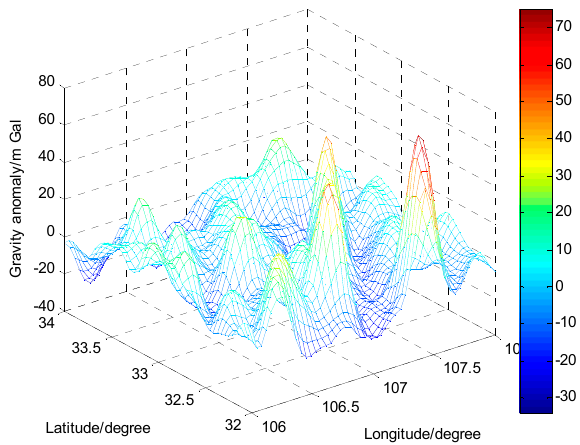
Figure 6. The gravity anomaly map in the Huabei plain area.